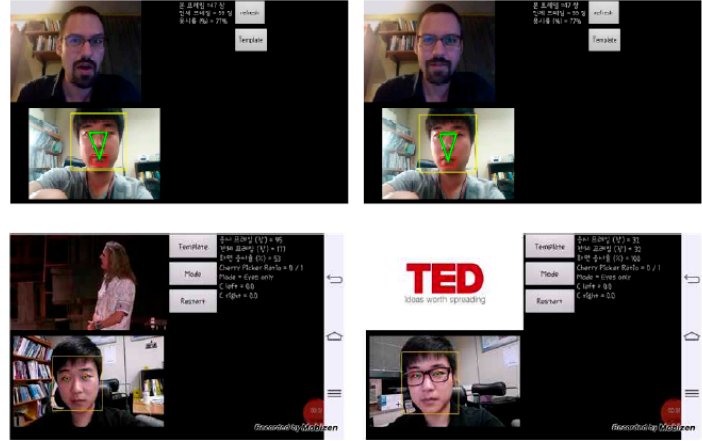
Figure 2. Administrator mode of the content viewing monitoring system.